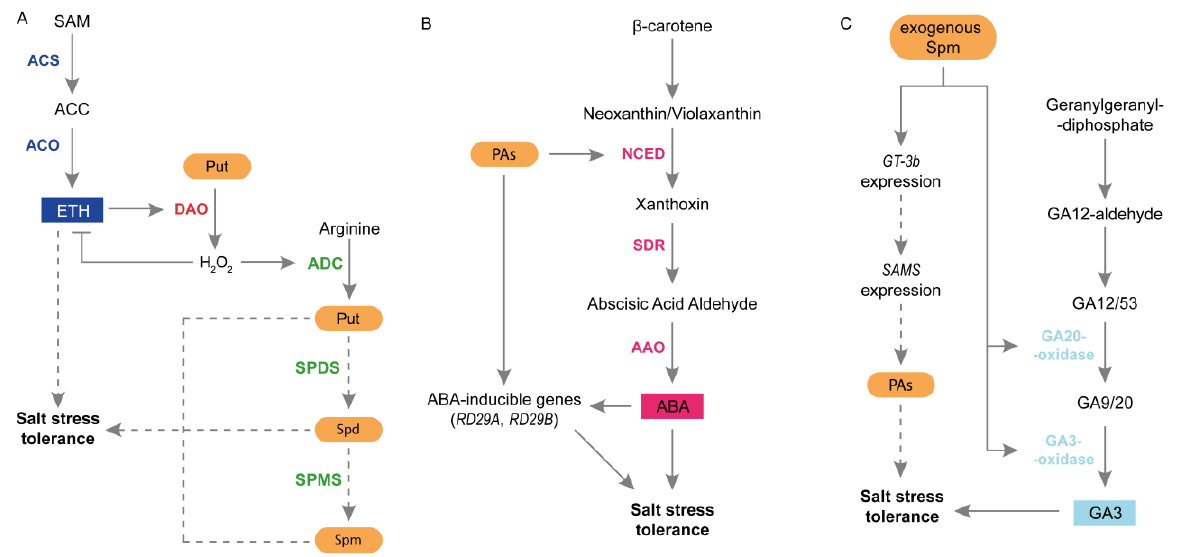
Figure 4. Interactions between PAs and plant hormones in plants subjected to salt stress. ( A ) Crosstalk between PAs and ETH during salinity stress in maize. In maize exposed to salt stress, the expression of ACS and ACO increased, leading to a higher ETH content. As a result, ETH stimulates DAO expression and activity, which oxidizes Put to H 2 O 2 . Next, H 2 O 2 plays a dual role. It reduces ETH production and prevents excessive ETH content, which may have an unfavorable effect on plants. Moreover, H 2 O 2 stimulates PA production by upregulating ADC expression and ACD activity. ( B ) Interactions between PAs and ABA in plant response to salt stress. PAs regulate the expression of NCED and ABA content. PAs also regulate the expression of other ABA-inducible genes, such as RD29A and RD29B , thereby inducing plant tolerance to salt stress. ( C ) PAs and GAs relationships during plant response to salt stress. Exogenous Spd stimulates the activity of GA20 oxidase and GA3 oxidase and up-regulates the expression of some genes involved in GA biosynthesis. Under salt-stress conditions, exogenous Spd enhances GA3 content and stimulates expression of the GT-3b transcription factor. Furthermore, exogenous Spd may promote the expression of SAMS via GT-3b and PAs production, thereby increasing plant tolerance to salt stress. AAO, abscisic aldehyde oxidase; ACC, 1-aminocyclopropane-1-carboxylic acid; ACO, 1-amino-cyclopropane-carboxylate oxidase; ACS, 1-amino-cyclopropane-carboxylate synthase; ADC, arginine decarboxylase; DAO, diamine oxidase; ETH, ethylene; GA, gibberellin; H 2 O 2 , hydrogen peroxide; NCED, 9-cis-epoxycarotenoid dioxygenase; PAs, polyamines; Put, putrescine; SAM, S-adenosyl-L-metionine; SAMS, S-adenosyl- L-metionine synthase; SDR, short-chain alcohol dehydrogenase/reductase; Spd, spermidine; SPDS, spermidine synthase; Spm, spermine; SPMS, spermine